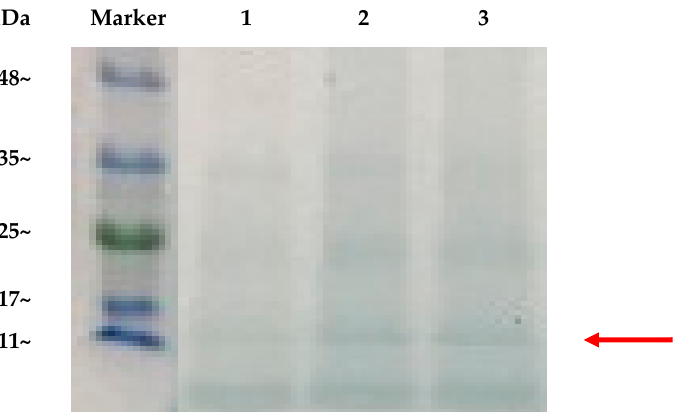
Figure 2. SDS-PAGE of peptides from wild bitter gourd extract under different hydrolysis conditions. Lane 1: enzyme hydrolysis 2 h; Lane 2: enzyme hydrolysis 2 h + 121 °C, 5 min; Lane 3: HPP assisted enzyme hydrolysis (300 MPa, 5 min). The arrow shows the small molecule fragment.